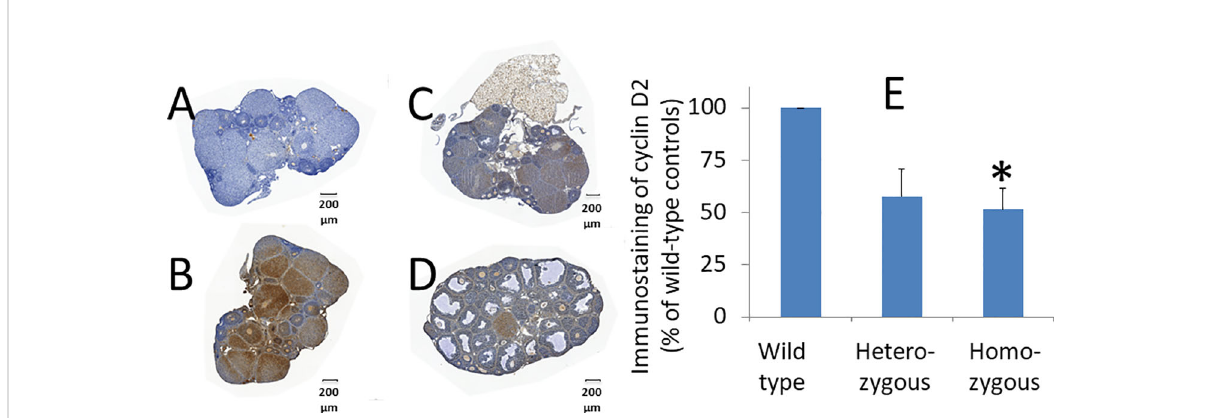
FIGURE 5 Effects of oocyte-speci fi c Adm2 disruption on cyclin D2 expression in growing follicles. The expression of immunoreactive cyclin D2 in ovaries of wild-type ( A , negative control and B , positive control), heterozygous (C) , and homozygous (D) mice at 44 hr after PMSG treatment (mean ± SEM). The immunoreactive cyclin D2 was detected using an anti-cyclin D2 antibody (Santa Cruz Inc.). Representative sections were shown at 100x magni fi cation. (E) Immunohistochemical DAB (3,3 ′ -diaminobenzidine) staining of representative sections was quanti fi ed with the HistoQuest software. The relative density of DAB staining is represented by vertical bars. The staining in wild-type ovaries was arbitrarily set as 100% (N =3). The difference in DAB staining between wild-type and heterozygous animals was at the border of signi fi cance ( p = 0.03). *, signi fi cantly different from the wild-type group at p <